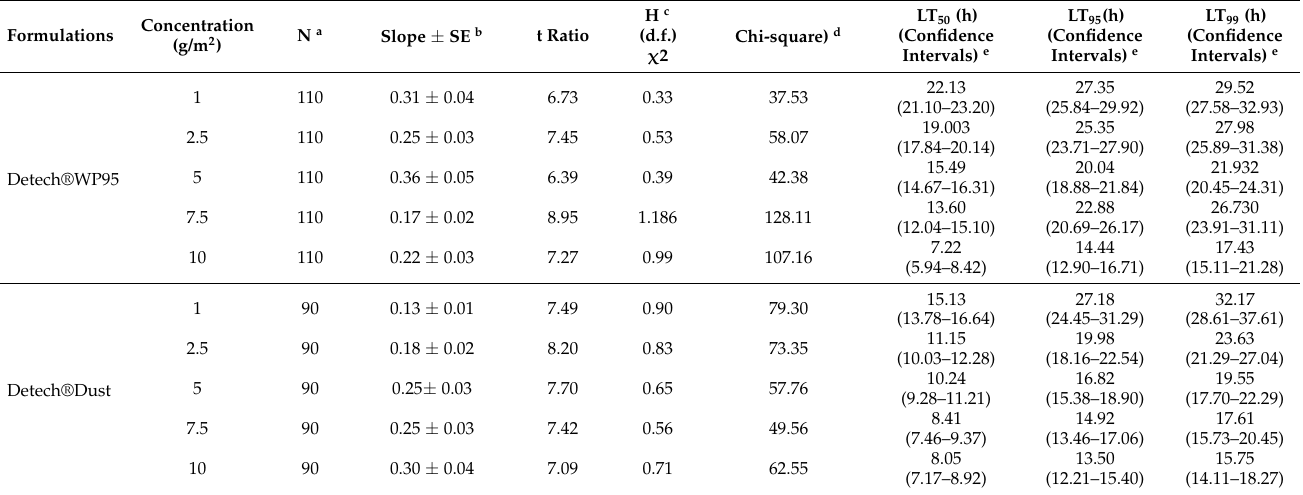
Figure 3. DE-treated ( a ) and untreated ( b ) Tyrophagus putrescentiae adults. The analysis of the lethal time of T. putrescentiae adults exposed to Detech ® WP and Detech ® Dust diatomaceous earth formulations at five different concentrations is provided in Table 4. The lethal time (LT 50 /LT 95 /LT 99 ) estimates for the Detech ® WP95 formulation applied to T. putrescentiae adults at the lowest concentration (1 g/m 2 ) and highest concen- tration (10 g/m 2 ) were 22, 27, and 34 h and 7, 14, and 24 h, respectively. For the Detech ® Dust formulation at the lowest concentration (1 g/m 2 ) and highest concentration (10 g/m 2 ), LT 50 , LT 95 , and LT 99 were 15, 27, and 44 h and 8, 13, and 21 h, respectively. Table 4. Toxicity of Detech ® WP95 and Detech ® Dust formulations expressed as LT 50 , LT 95 , and LT 99 values for T. putrescentiae adults after exposure to five